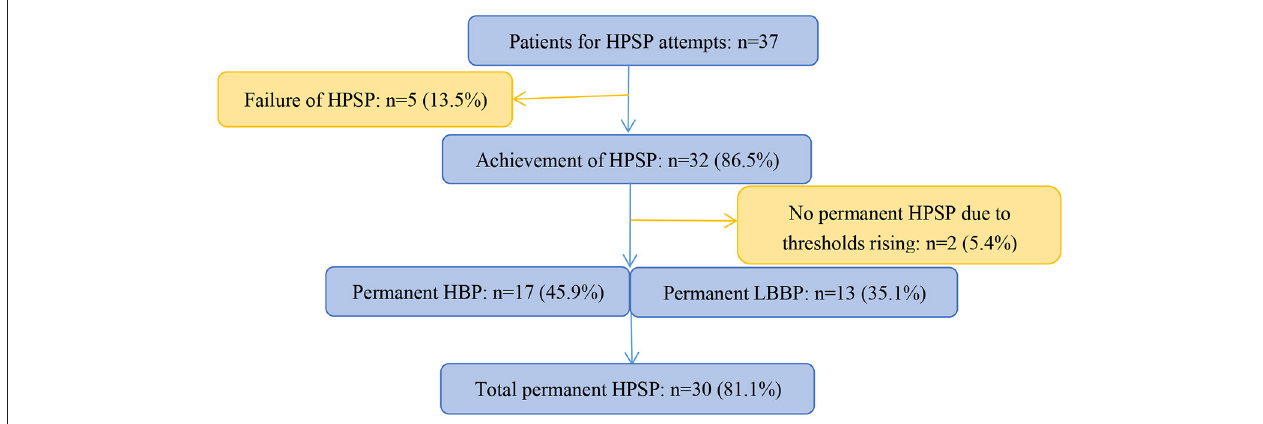
FIGURE 3 | Schematic summary of study and patient flow. HPSP, His-Purkinje system pacing; HBP, His bundle pacing; LBBP, left bundle branch pacing.